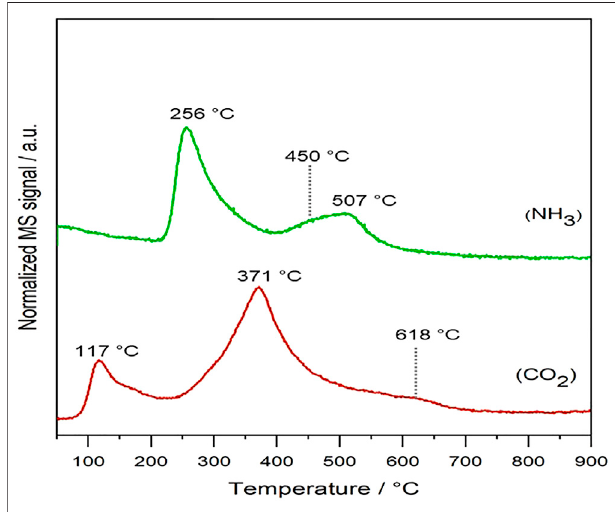
FIGURE 2 | NH 3 -TPD and CO 2 -TPD patterns of the MgAl 2 O 4 catalyst. Note: a.u. is equivalent to arbitrary